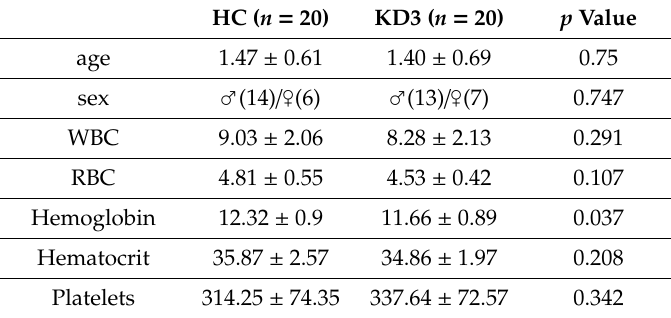
Table 4. Demographic and Clinical Characteristics of Enrolled